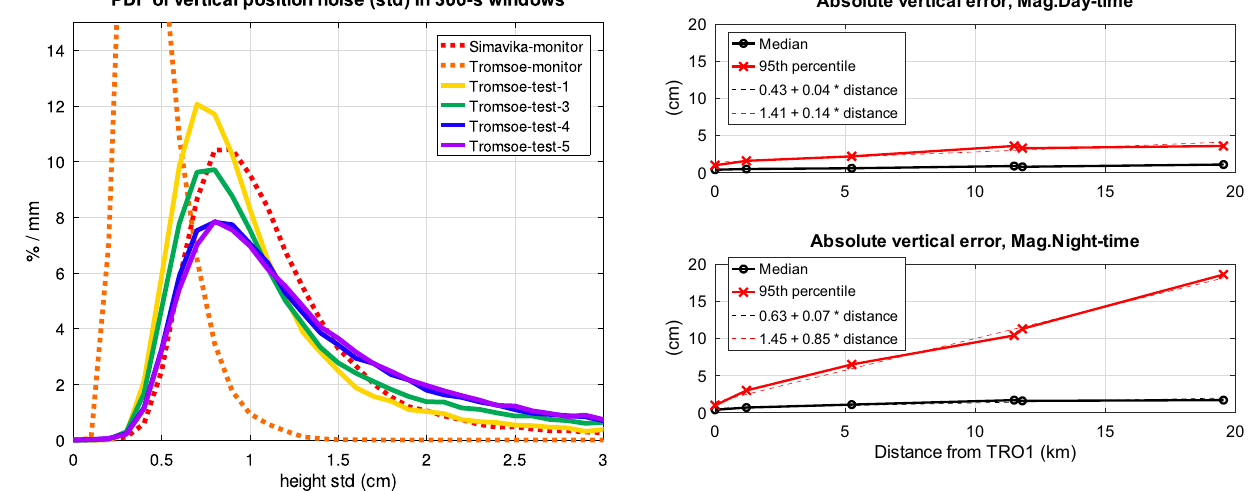
Fig. 10 Probability density function of vertical position standard deviation, using the entire dataset for each receiver